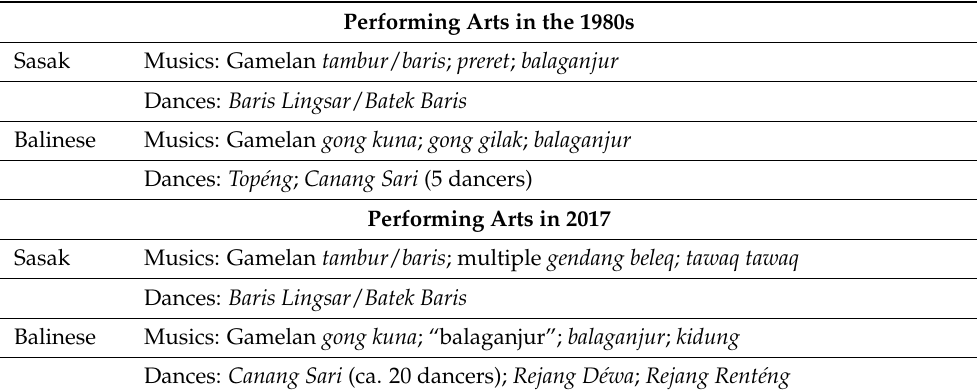
Table 1. Changes in Performing Arts at Lingsar over Three Decades. Performing Arts in the